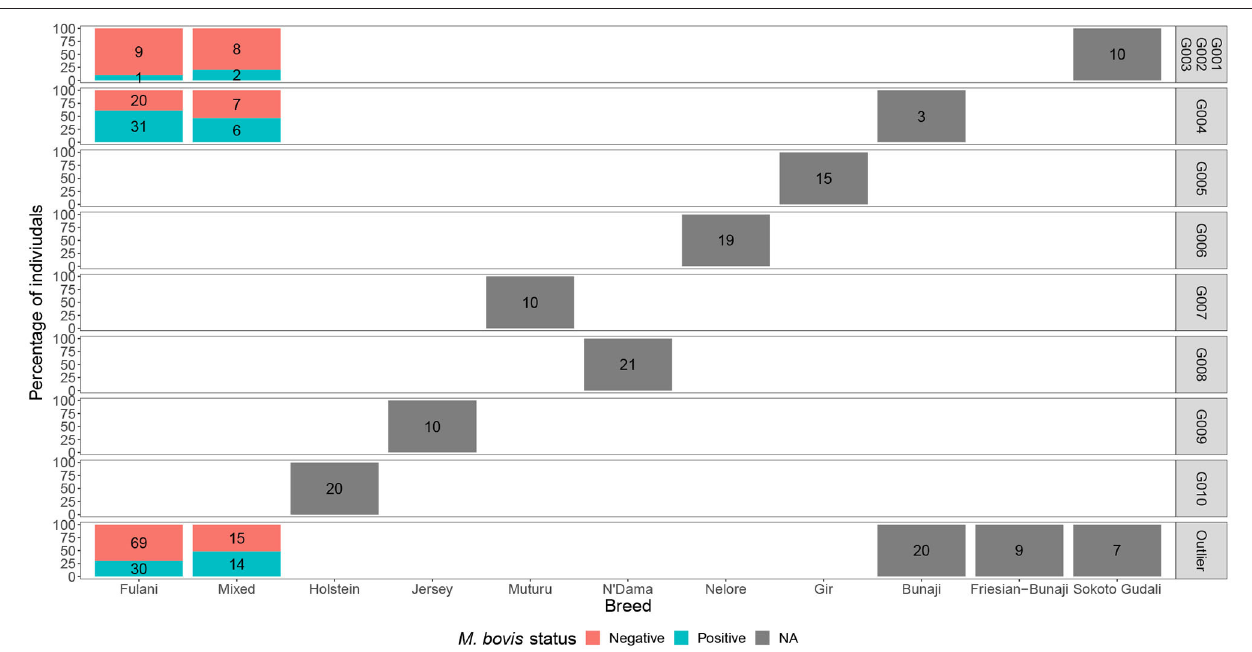
FIGURE 8 | The percentage of individuals belonging to each hierarchical cluster group as shown in Figure 3 broken down by the local abattoir employees definition of breed and M. bovis status. The labels refer to number of individuals belonging to each group.